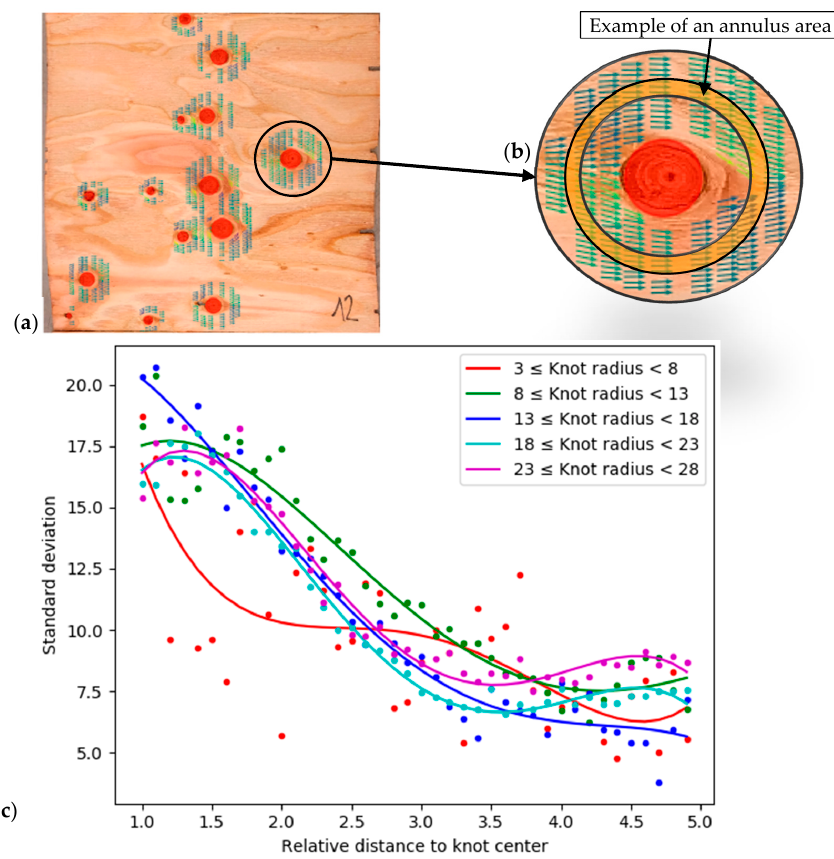
Figure 10. ( a ) Fiber angle measured with the threshold around the knots; ( b ) magnification of a knot with an example of the annulus measurement area; ( c ) standard deviations of angles in annulus areas for different knot sizes (mm).